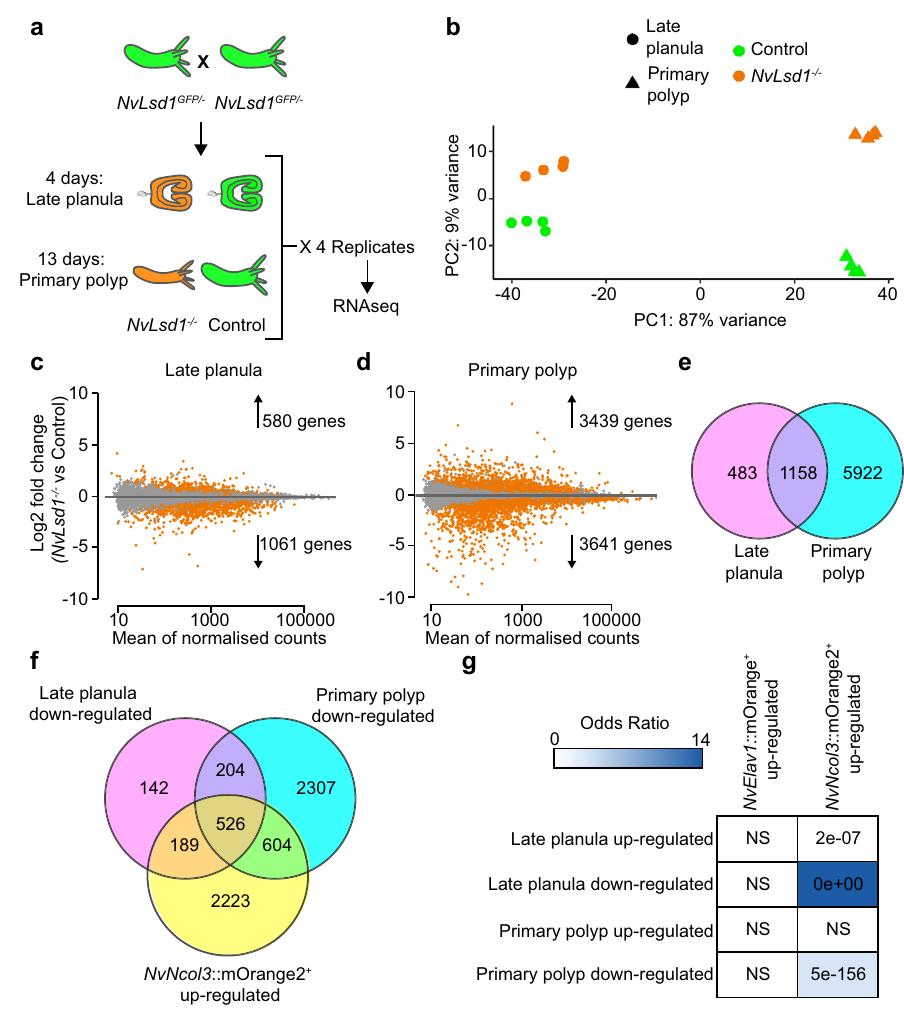
Fig. 4 Transcriptomic analysis of NvLsd1 mutants. a Cartoon depicting the experimental design for the transcriptome analysis of NvLsd1 mutants. Controls are shown in green, and mutants are shown in orange. b PCA plot using the gene counts after variance stabilizing transformation (VST). Late planula samples are shown as circles and primary polyp as triangles. Experimental conditions are encoded with color: green for controls and orange for mutants. c , d MA-plots of up- and down- regulated genes between NvLsd1 − / − and control in late planula ( c ) and primary polyps ( d ). Differentially expressed genes are shown in orange at signi fi cance level of 0.05. e Venn diagram comparing all differentially expressed genes at late planula and primary polyp stages. f Venn diagram comparing genes downregulated in NvLsd1 − / − late planula and primary polyp with genes upregulated in NvNcol3 ::mOrange2 + cells. g Comparison of the overlap between up- and downregulated genes in NvLsd1 − / − late planula and primary polyps with those upregulated in NvNcol3 ::mOrange2 + and NvElav1 ::mOrange + cells using the GeneOverlap R package. The strength of the blue color indicates the odds ratio and numbers indicate the p -value, calculated using one-sided Fisher ’ s exact